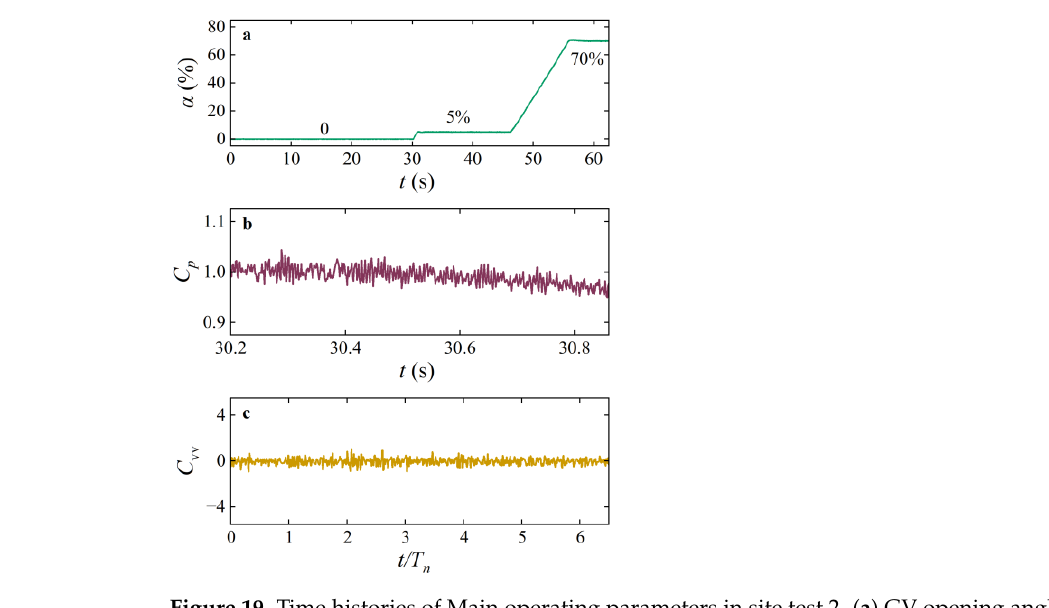
Figure 19. Time histories of Main operating parameters in site test 2. ( a ) GV opening angle after the ball valve starts to open; ( b ) static pressure coefficient in vaneless space within a GV opening range of 0 to 5%; ( c ) α = 0.2° for GV-M horizontal vibration velocities of the guide vane blade within a GV opening range of 0 to 5%.